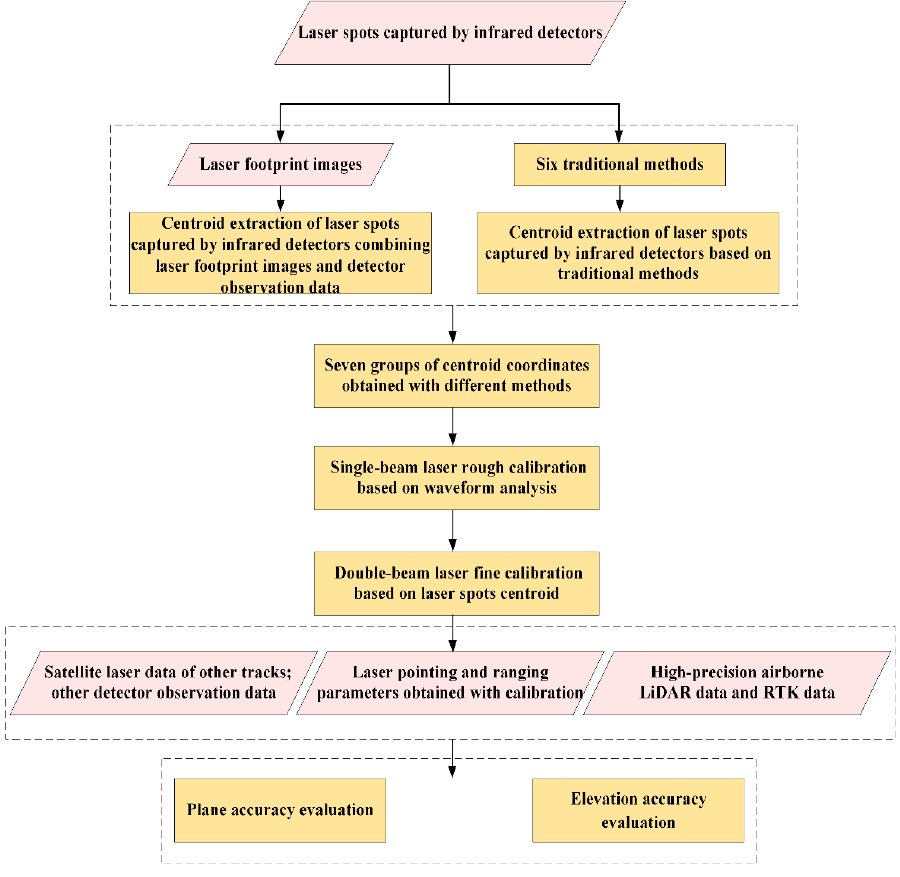
Figure 6. Experimental flow chart.